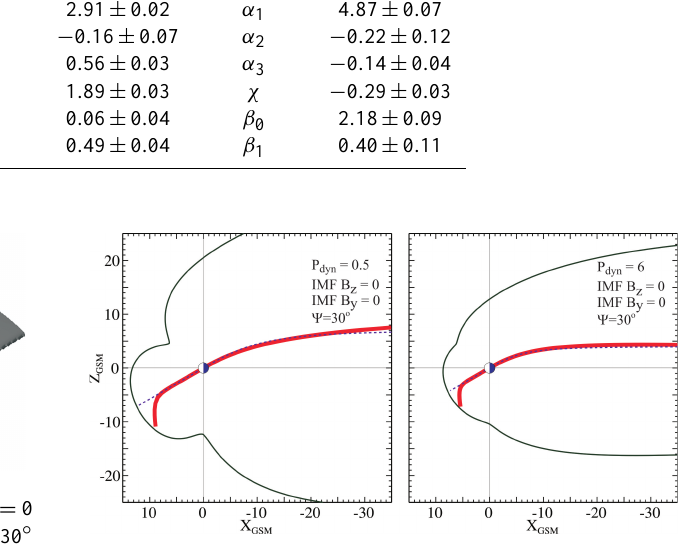
Figure 6. Illustrating the effect of the solar wind P dyn on the size and shape of the model surface B r = 0. In both cases, IMF B y = B z =